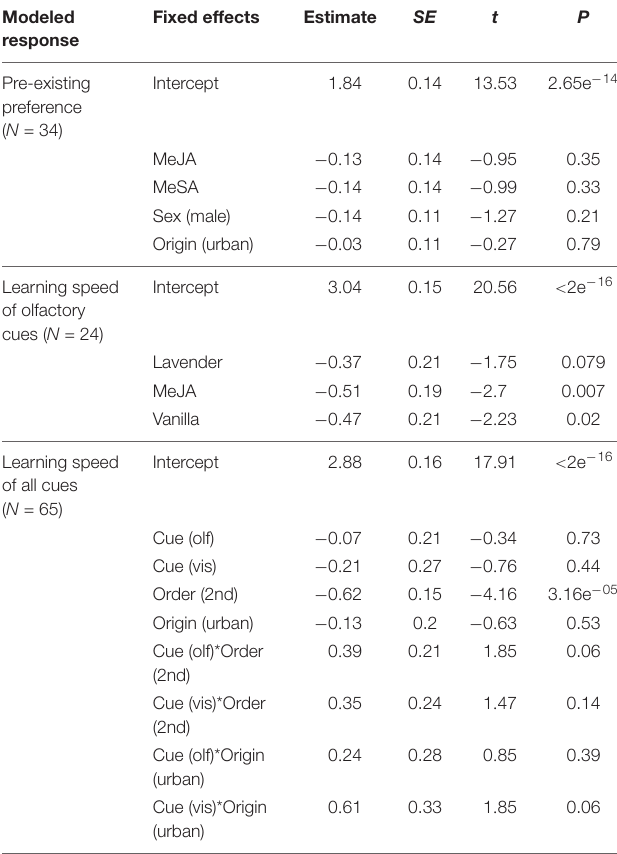
TABLE 1 | Results of generalized linear mixed models (GLMM) analyses showing fixed effects of models for (1) pre-existing odor preference, (2) learning speed of olfactory herbivore-induced plant volatile (HIPV) and neutral cues, and (3) learning speed of olfactory, visual, and multimodal cues. Modeled